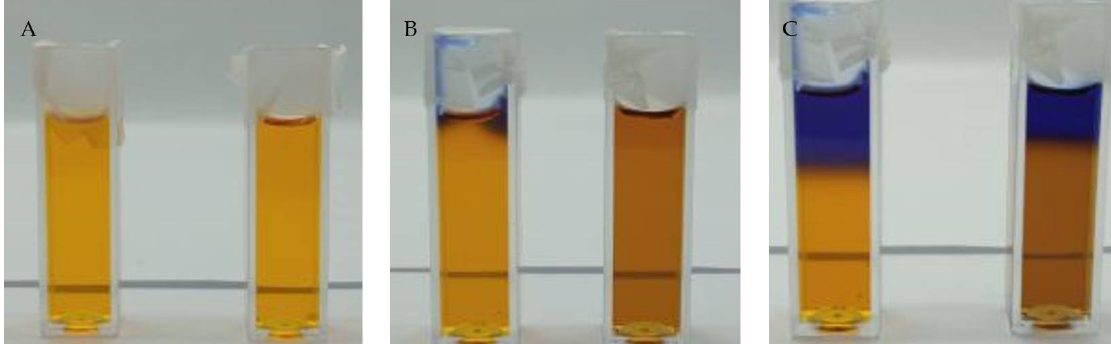
Figure 3. Photographs of the Fricke-XO-Pluronic F-127 dosimeter samples without and with 0.2 M NaCl, which were stored at room temperature and exposed to daylight: ( A )—immediately after preparation, ( B )—24 h, ( C )—48 h. The samples on the right-hand side contain NaCl.